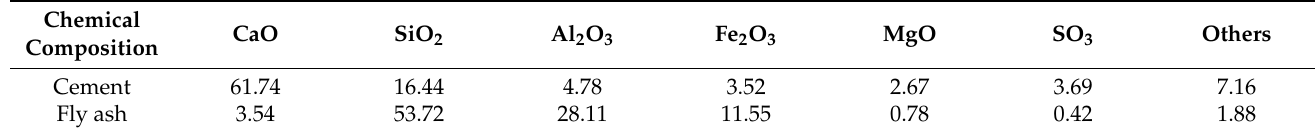
Table 1. Chemical composition of cement and fly ash (wt%).